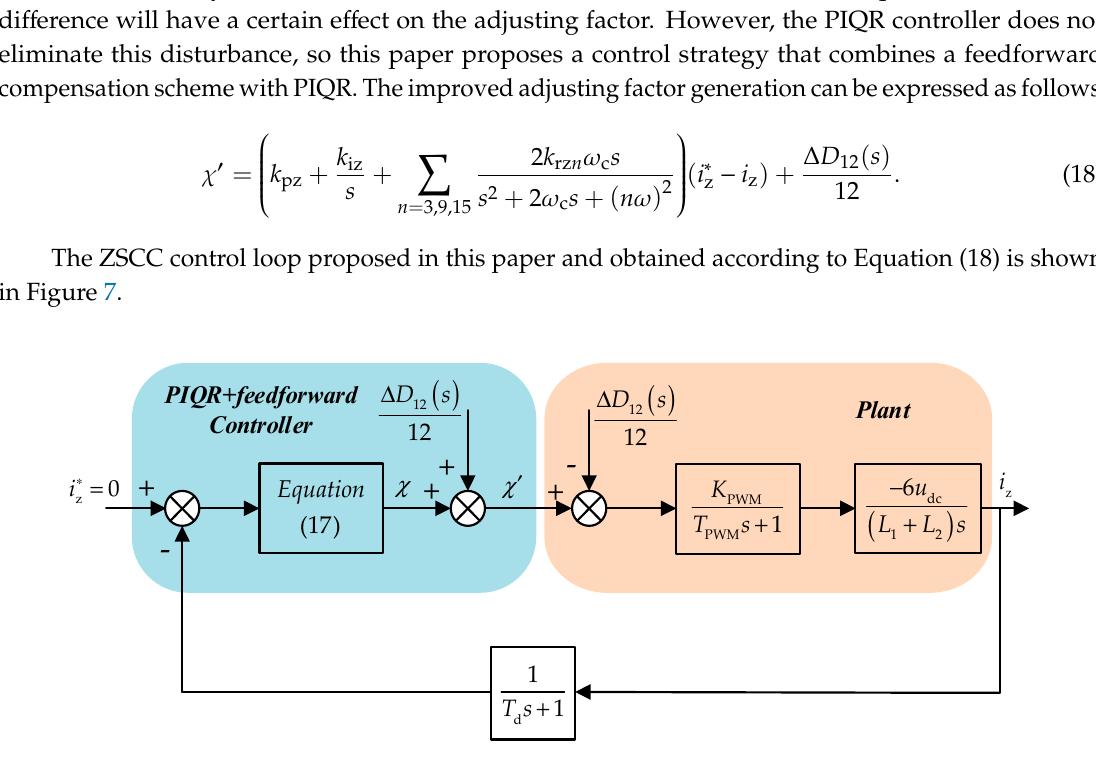
Figure 7. Control block diagram of suppressing ZSCC in two paralleled converters using the proposed control strategy.